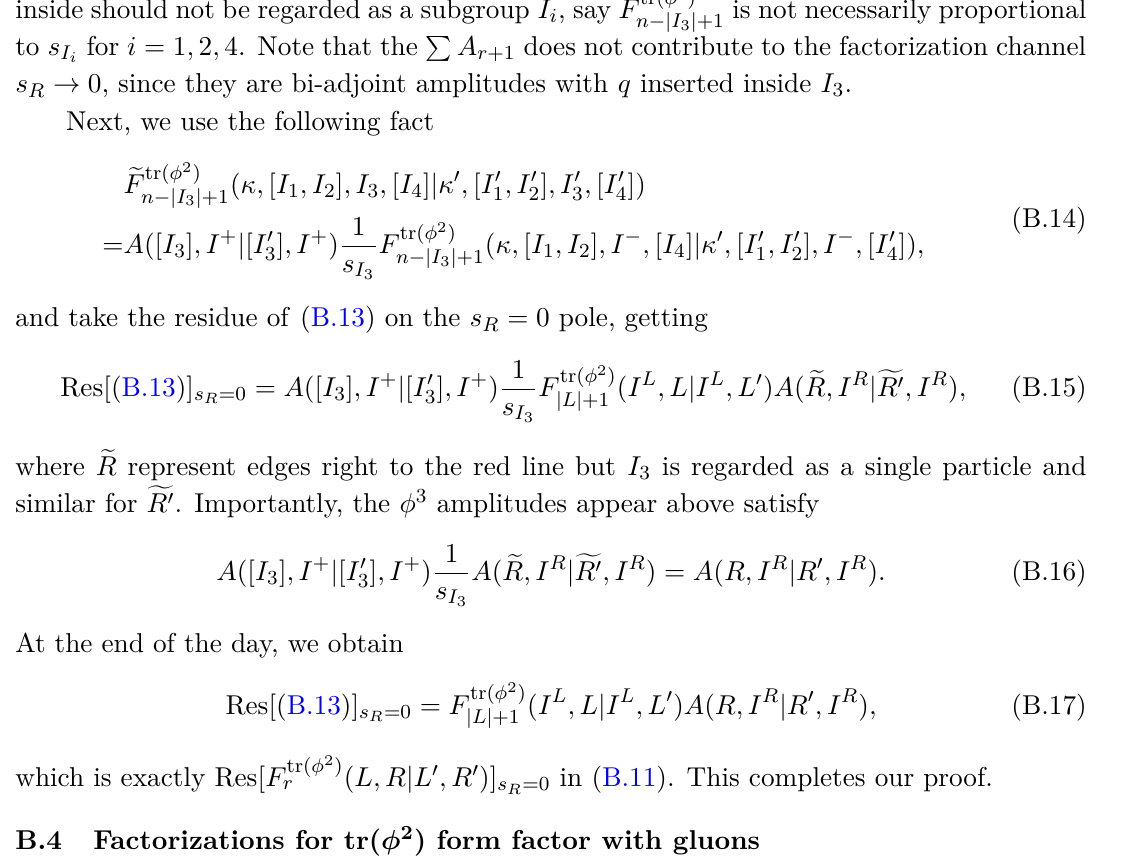
Figure 9. (a): the mutual partial triangulation for a form factor F tr( φ ization channel s is denoted by red line and the edges left(right) to the red line is represented by R L ( R ) . (b): a lower point mutual partial triangulation for F tr( φ step for the expansion of original form factor that “contains”